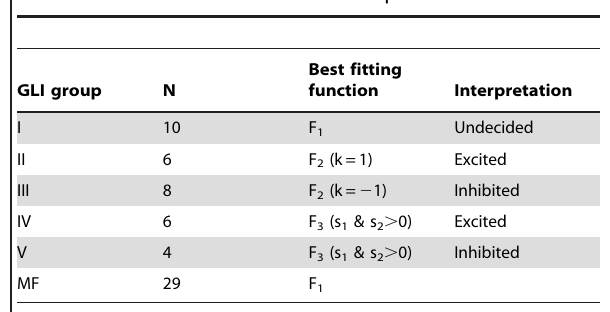
Table 1. Types of GLIs categorized based on their response profile during the ‘‘Off-center fixation’’ task; mossy fibers (MF) are shown in the bottom row for comparison.